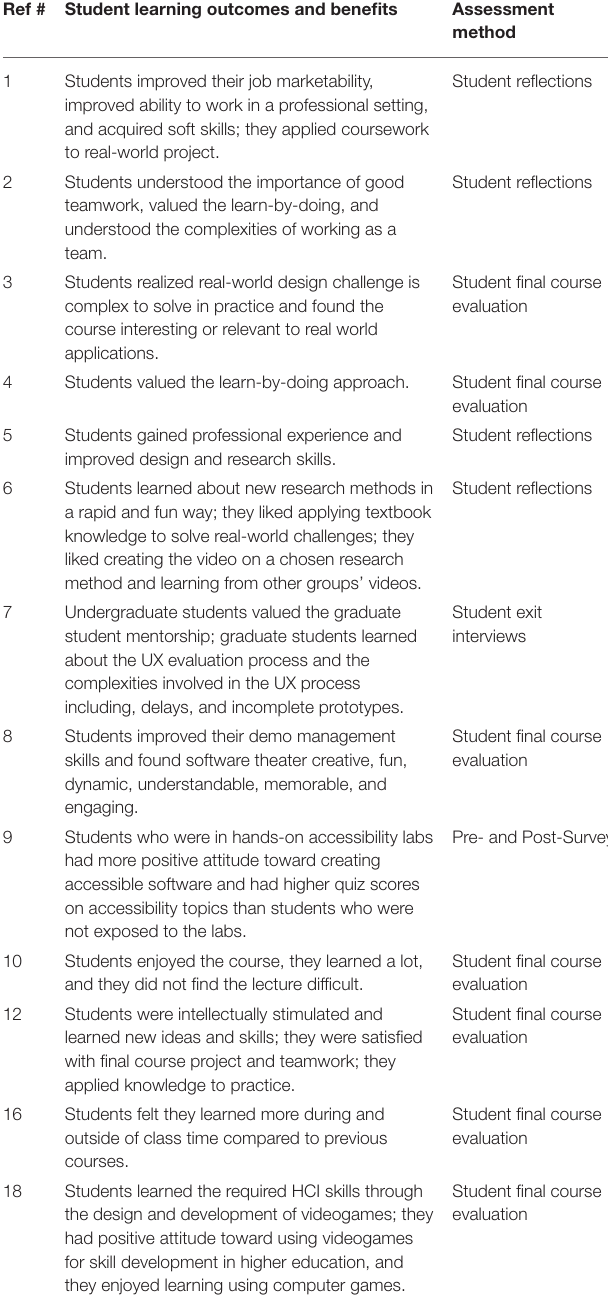
TABLE 8 | A list of learning outcomes and benefits reported in the